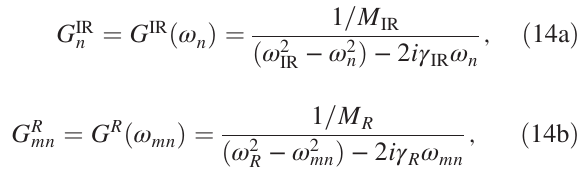
Figure 3 shows the magnitude and phase of χ ð 3 Þ ð 2; 1 ; − 1 ; 2 Þ schematically when coupling between a = 2 π ¼ 20 THz, and a single single IR phonon at f ¼ ω IR IR = 2 π ¼ 12 THz is allowed Raman phonon at f ¼ ω R R through the nonlinear dipole moment. The curves indicate 3 Þ the contribution from χ ð , i.e., from IRRS. Two peaks are b;b